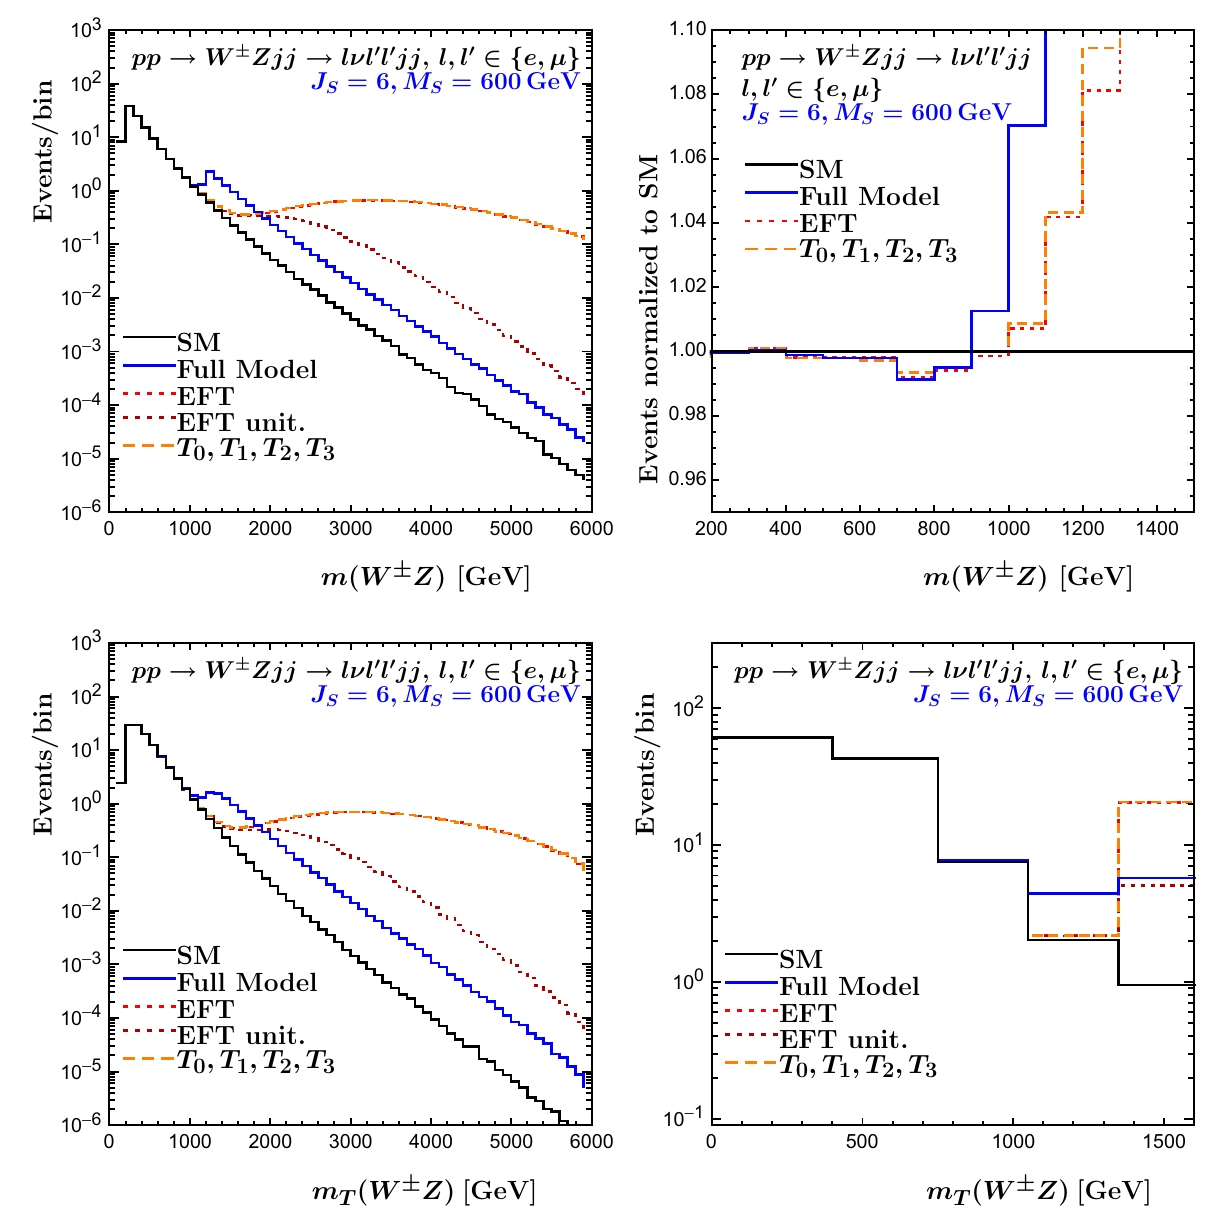
Bin width in the two left panels is 100GeV, while on the lower right bin size is chosen as in Ref. [3]. The considered scenario is a scalar multiplet with J S = 6 and M S =